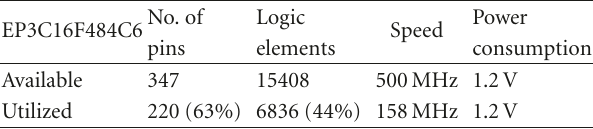
Table 7: Characteristics for the chip in Figure